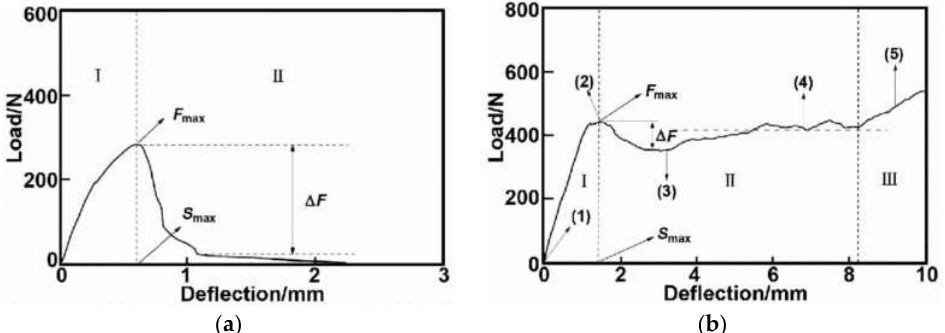
Figure 11. Load-displacement curves of ( a ) adhesive bonded AFS [39] and ( b ) metallurgical bonding AFS [39] (Pictures a and b are copied from other published papers, if original pictures were needed, please check the references.).